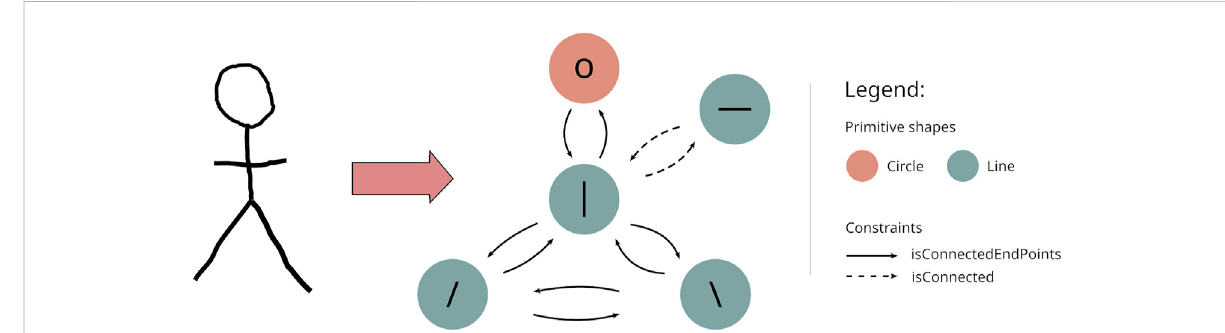
FIGURE 3 An actor being drawn (left side) and the resulting graph G (right side). Each edge is a relation between two primitive shapes connected at their end points or intersecting. The orange node represents the head of the actor. Green nodes are straight lines whose orientations are indicated by the node